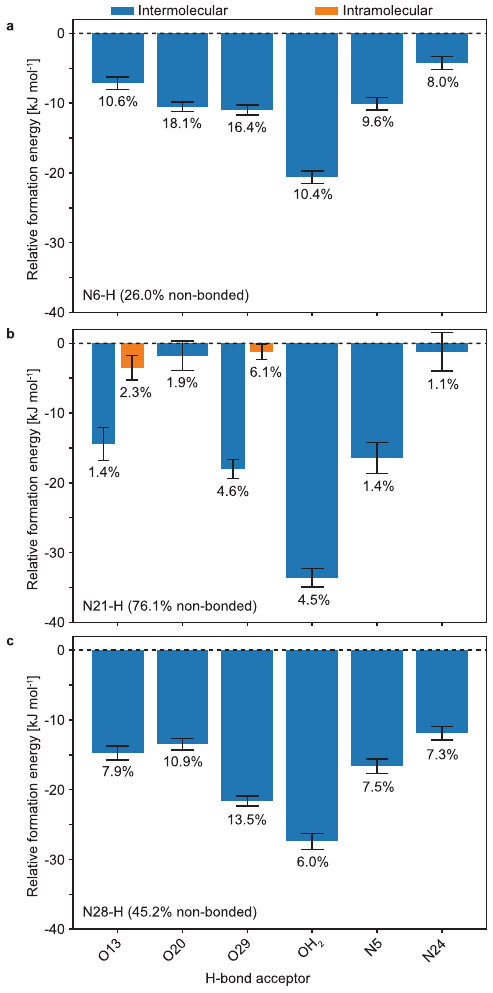
Fig. 6 Relative formation energy of the hydrogen bonding motifs. Mean computed formation energies of intermolecular complexes for the H-bond acceptor connected to a N6-H, b N21-H or c N28-H of the probe molecule. The percentage under each bar indicates the fraction of the N-H group bonded to the corresponding H-bond acceptor. Only the H-bond acceptors making up at least 1% of all instances analysed are displayed. The error bars indicate the standard error of the mean of the relative formation